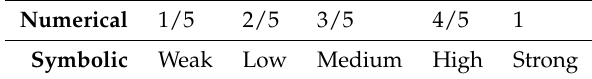
Table 4. Symbolic names for the numerical attribute scale (Source: Authors). Numerical 1/5 2/5 3/5 4/5 1 Symbolic Weak Low Medium High